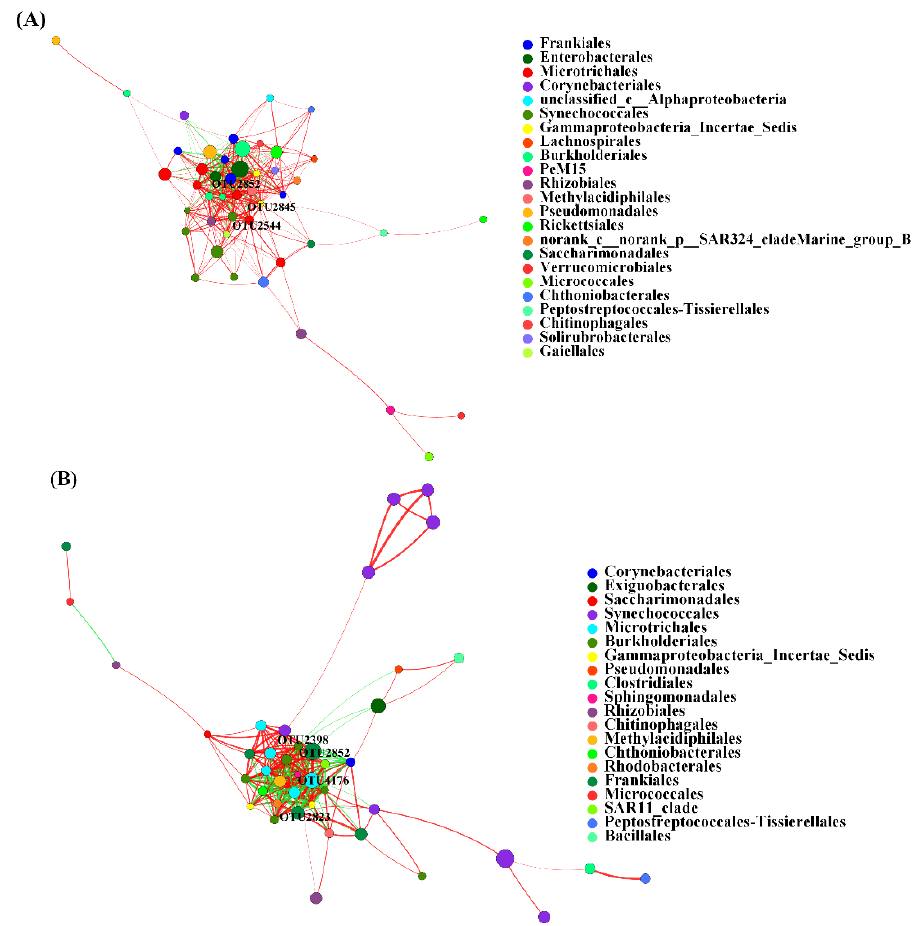
Figure 6. The OTU co-occurrence network of B. calyciflorus -associated bacterial and bacterioplankton communities. ( A ) B. calyciflorus -associated bacteria (AB); ( B ) bacterioplankton (NB). The nodes are colored according to order. Green edges represent positive correlations, and red edges represent negative correlations. Node size is proportional to the betweenness centrality of each OTU, and edge thickness is proportional to the weight of each correlation.